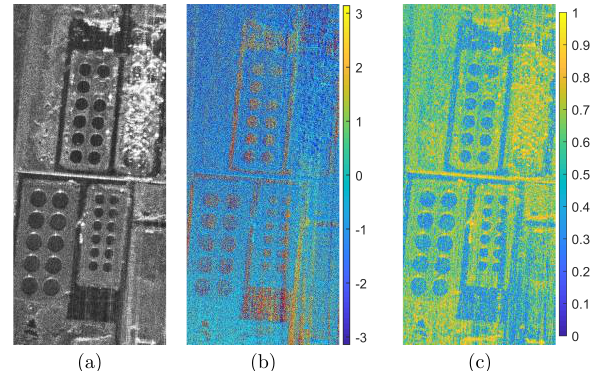
Figure 9. Actual InSAR system data processing with RD algorithm. ( a ) Imaging result of Scene with RD algorithm; ( b ) Interferometric phase after MoCo; ( c ) Coherence